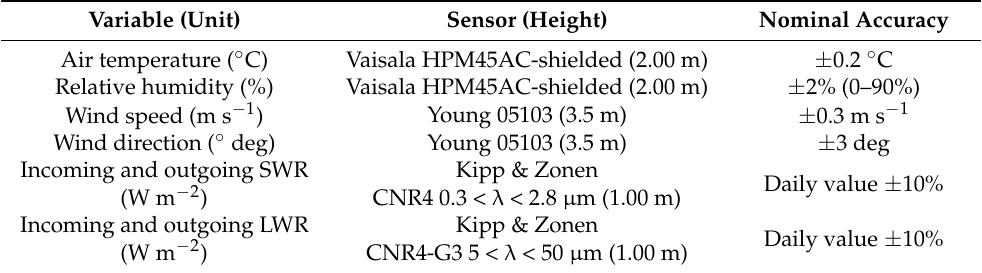
Table 1. List of sensors installed in the PRAA-Morrena station located in the Antisana glacier 12. Variable (Unit) Sensor (Height) Nominal Accuracy Air temperature ( ◦ C) Vaisala HPM45AC-shielded (2.00 m) ± 0.2 ◦ C Relative humidity (%) Vaisala HPM45AC-shielded (2.00 m) ± 2% (0–90%) Wind speed (m s − 1 ) Young 05103 (3.5 m) ± 0.3 m s − 1 Wind direction ( ◦ deg) Young 05103 (3.5 m) ± 3 deg Incoming and outgoing SWR Kipp & Zonen Daily value ± 10% (W m − 2 ) CNR4 0.3 < λ < 2.8 µ m (1.00 m) Incoming and outgoing LWR Kipp & (W m − 2 )